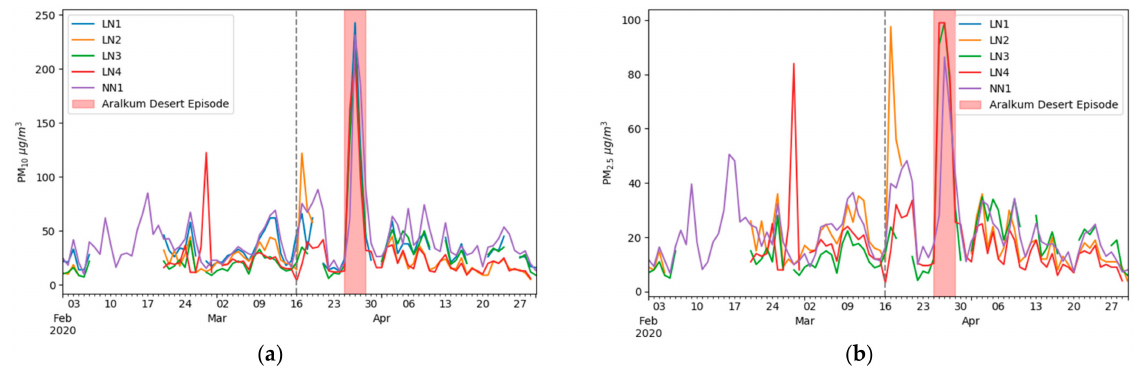
Figure 2. Daily concentrations at sites belonging to national and local monitoring networks before and after entering the state of emergency (dashed gray line) ( a ) PM 10 ( b ) PM 2.5